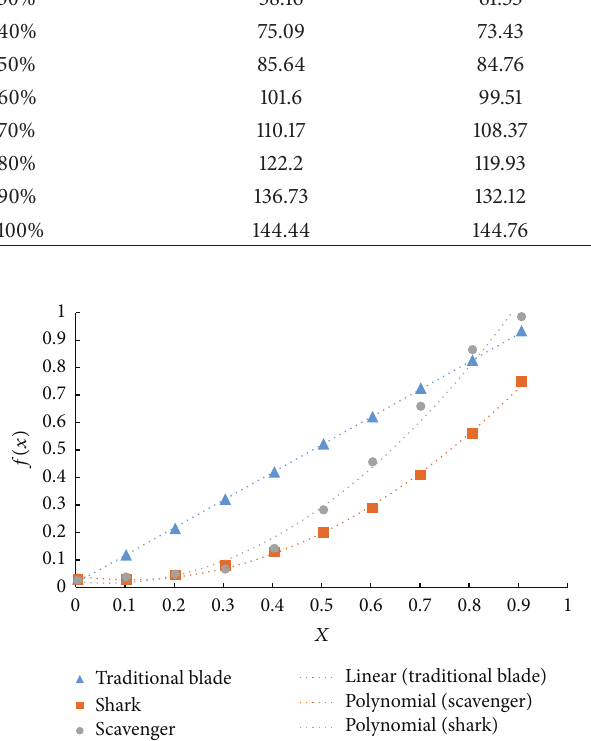
Figure 8: Fish and conventional stator blade distribution and polynomial fitting